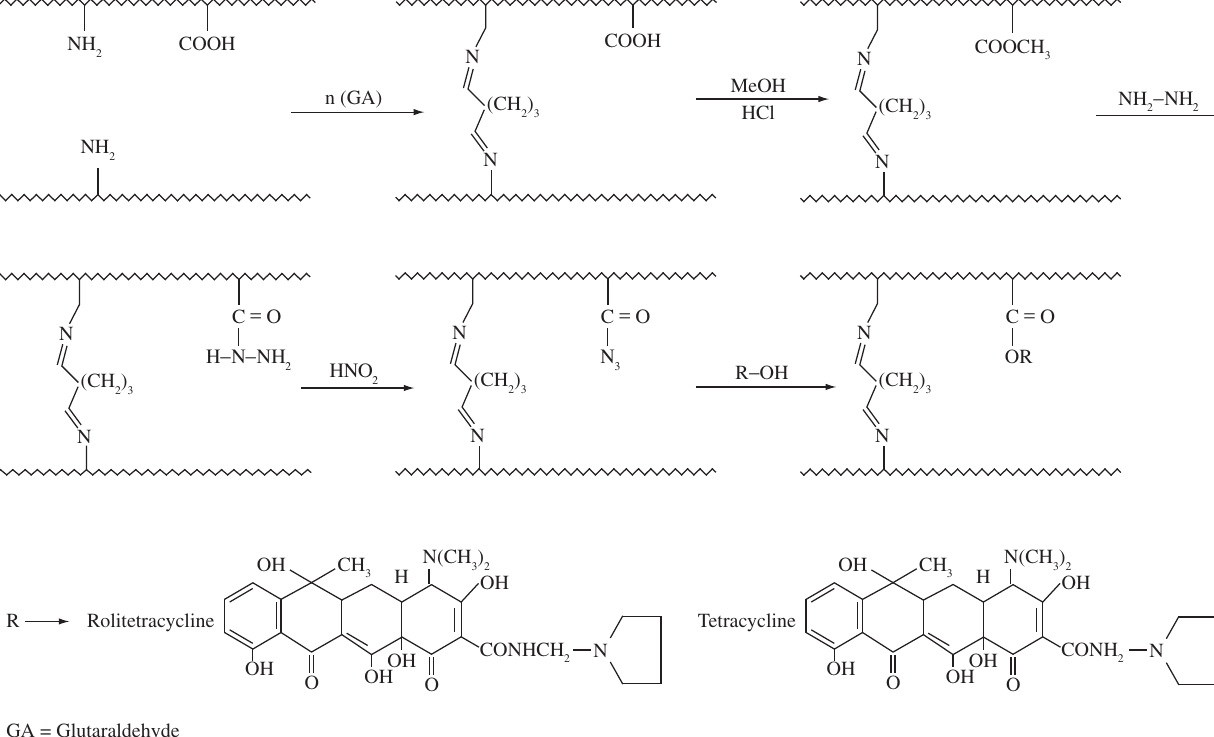
Figure 2. Schematic representation the reaction steps involved in the incorporation of tetracycline and rolitetracycline aver anionic collagen membranes by the azide